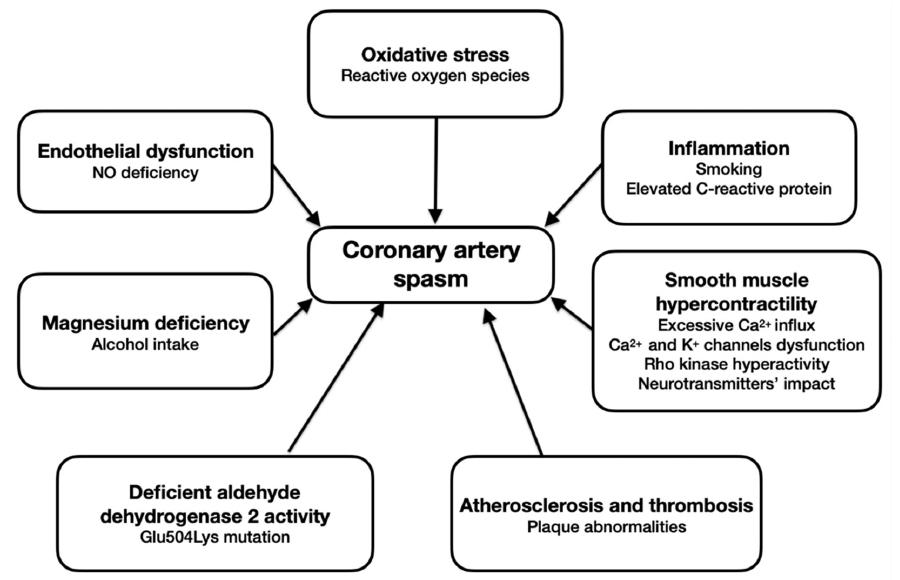
Figure 1. Pathogenetic mechanisms of